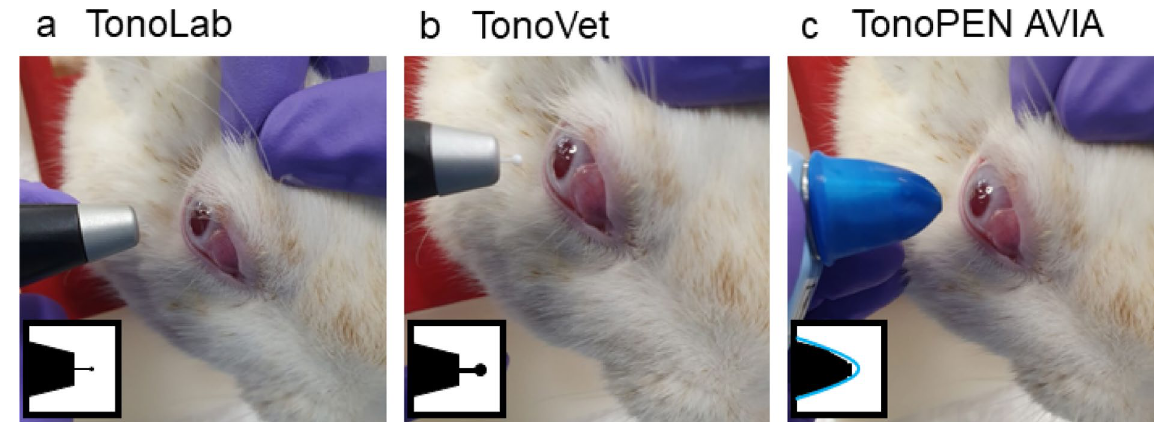
Figure 1. Measuring IOP in a rabbit using different tonometers. ( a ) TonoLab (rebound tonometer), ( b ) TonoVet (rebound tonometer), ( c ) TonoPEN AVIA with a single-use blue Ocu-Film tip-cover (applanation